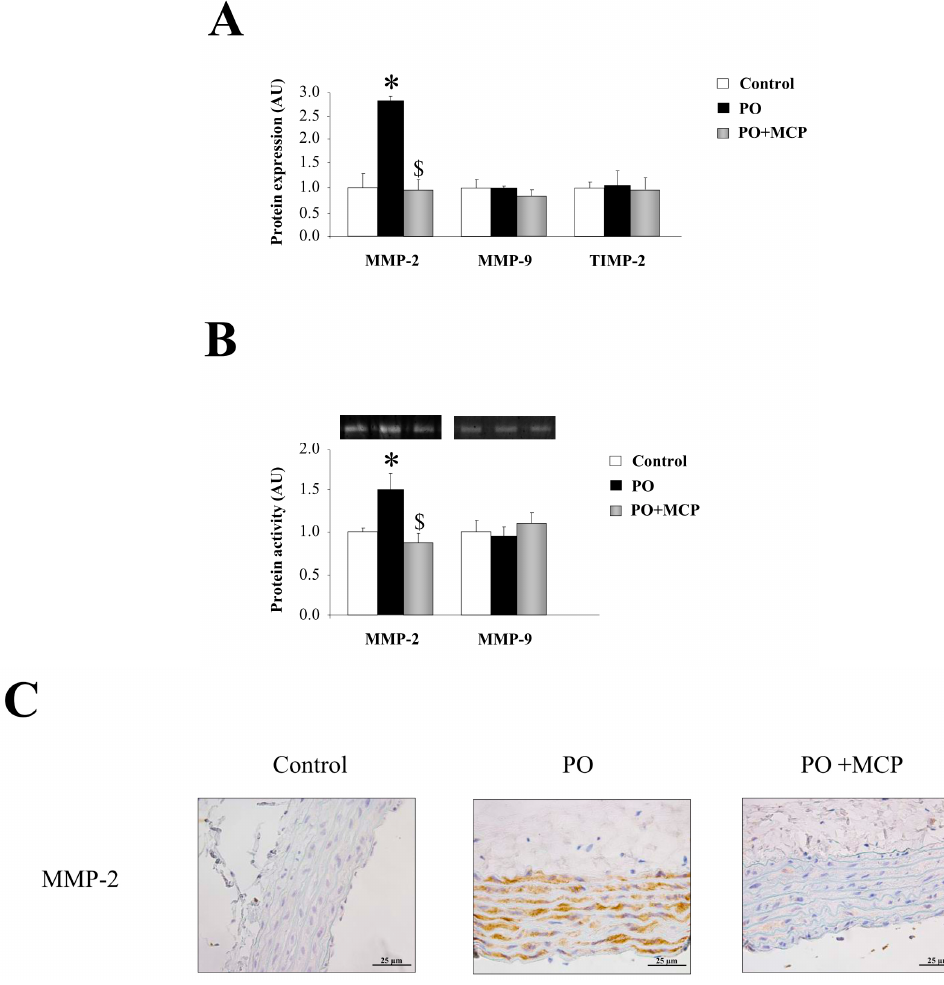
Figure 3. Pharmacological inhibition of Gal-3 blocks matrix metalloproteinase (MMP)-2 activity. Normalized values of the protein levels of MMP-2 (ng/mL), MMP-9 (pg/mL), and tissue inhibitor of metalloproteinase (TIMP)-2 (pg/mL) in aorta from controls, PO, and PO + MCP rats measured by ELISA ( A ); MMPs activities assessed by zymography ( B ); Representative pictures of aortic sections immunostained for MMP-2 ( C ). Histogram bars represent the mean ± SEM of each group of rats in arbitrary units. Magnification 40×. (Control rats, n = 7; Pressure Overload rats, PO, n = 7; and Pressure Overload rats treated with MCP, PO + MCP, n = 7). * p < 0.05 vs. control group; $ p < 0.05 vs. PO group.